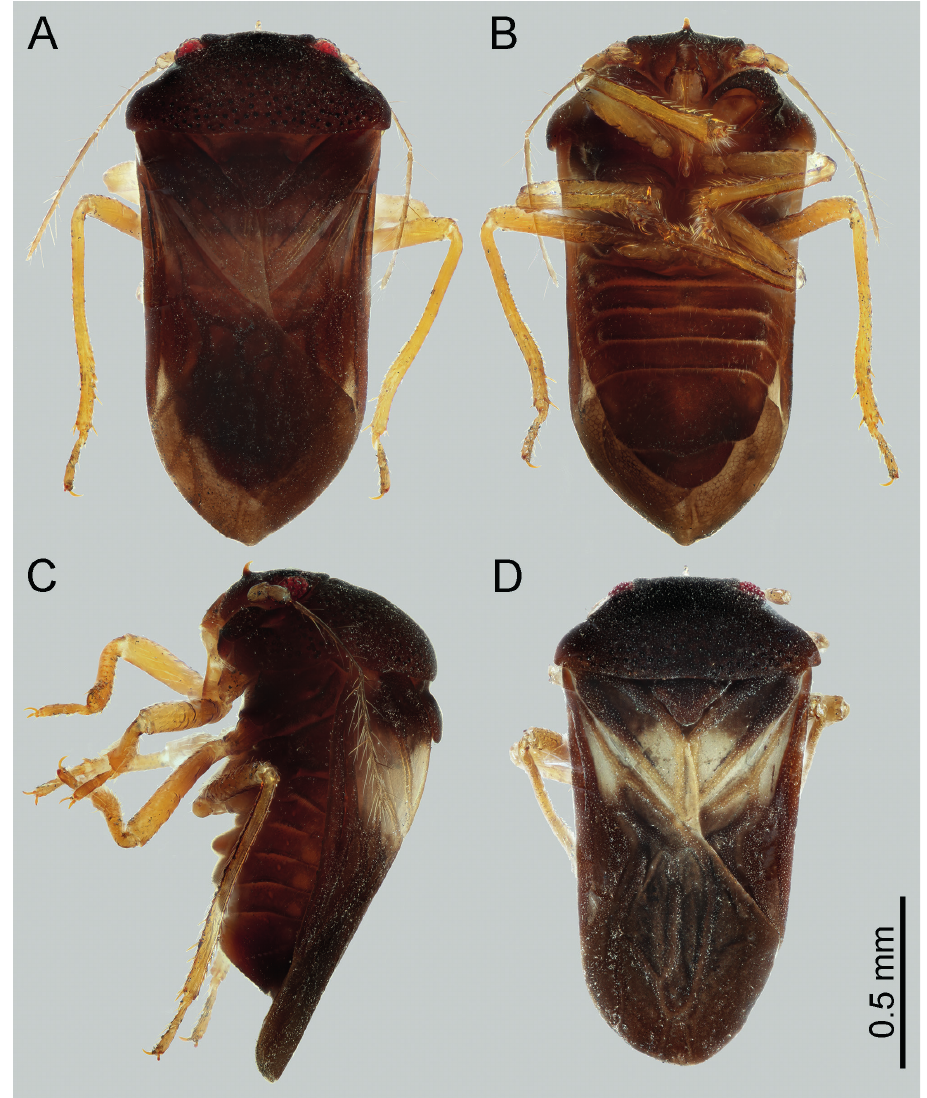
Figure 1. Habitus of Cornonannus bui gen. et sp. nov. A–C male holotype A in dorsal view B in ventral view C in lateral view D male paratype in dorsal view (in dry